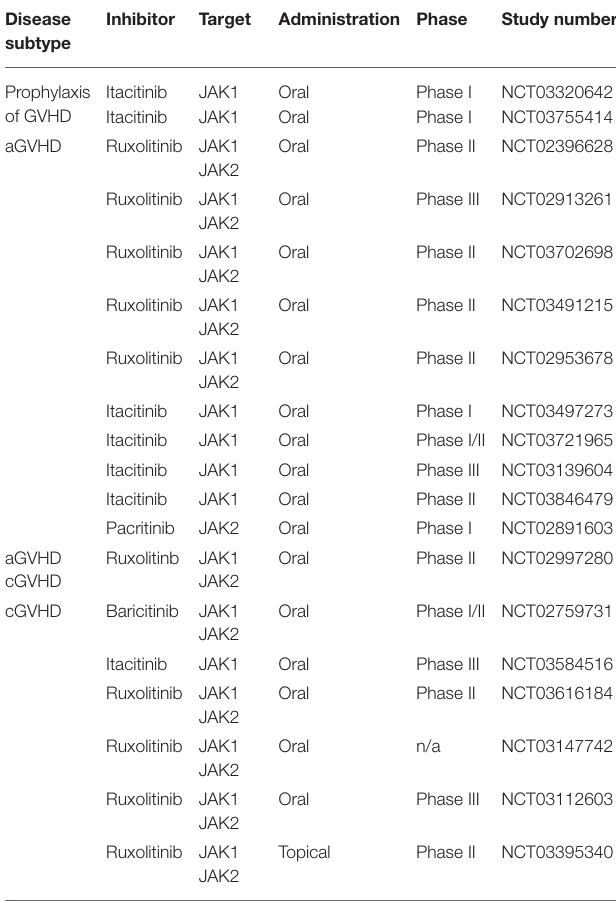
TABLE 5 | Clinical trials using JAKi in Graft-versus-Host-Disease according to clinicaltrials.gov. Disease subtype